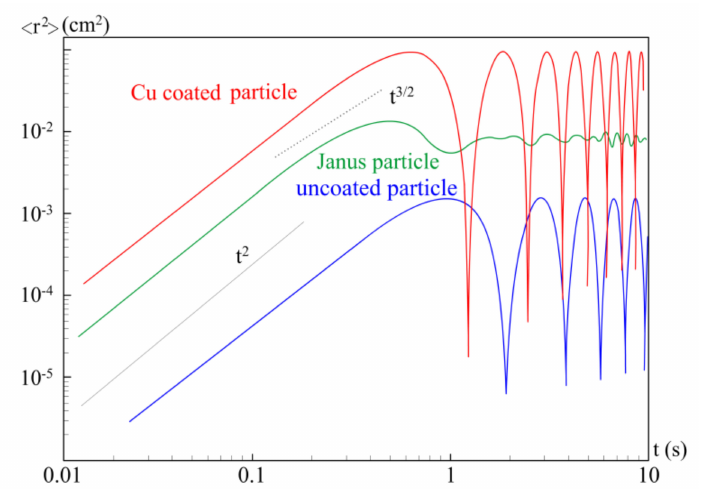
Figure 3. Mean square displacement of motion under exposure of laser with radiation power 1600 W for uncoated MF particles (blue), for copper coated MF particles (red) and Janus particles